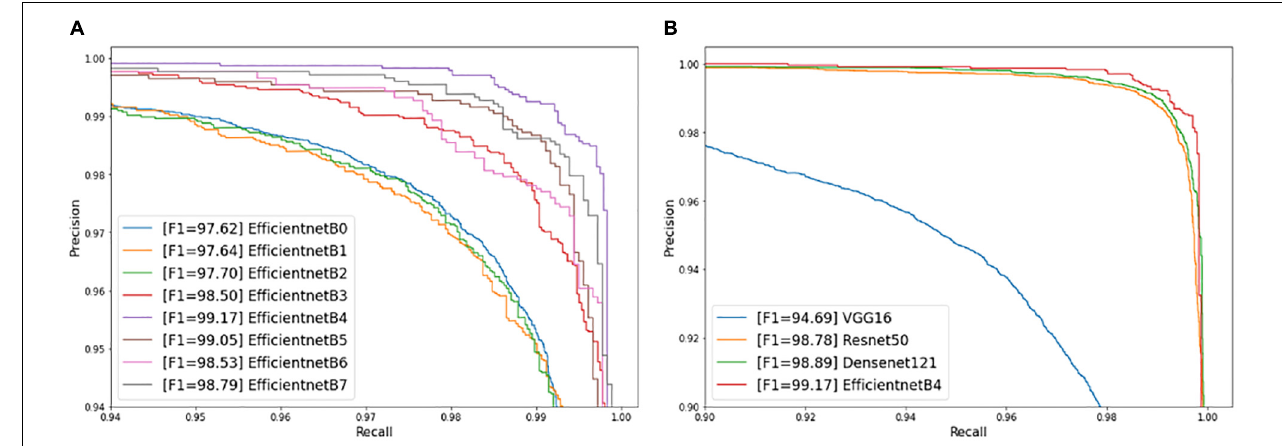
FIGURE 7 | Precision–Recall curves of different deep learning models: (A) EfficientnetB0-B7 (B) State-of-art CNN models.